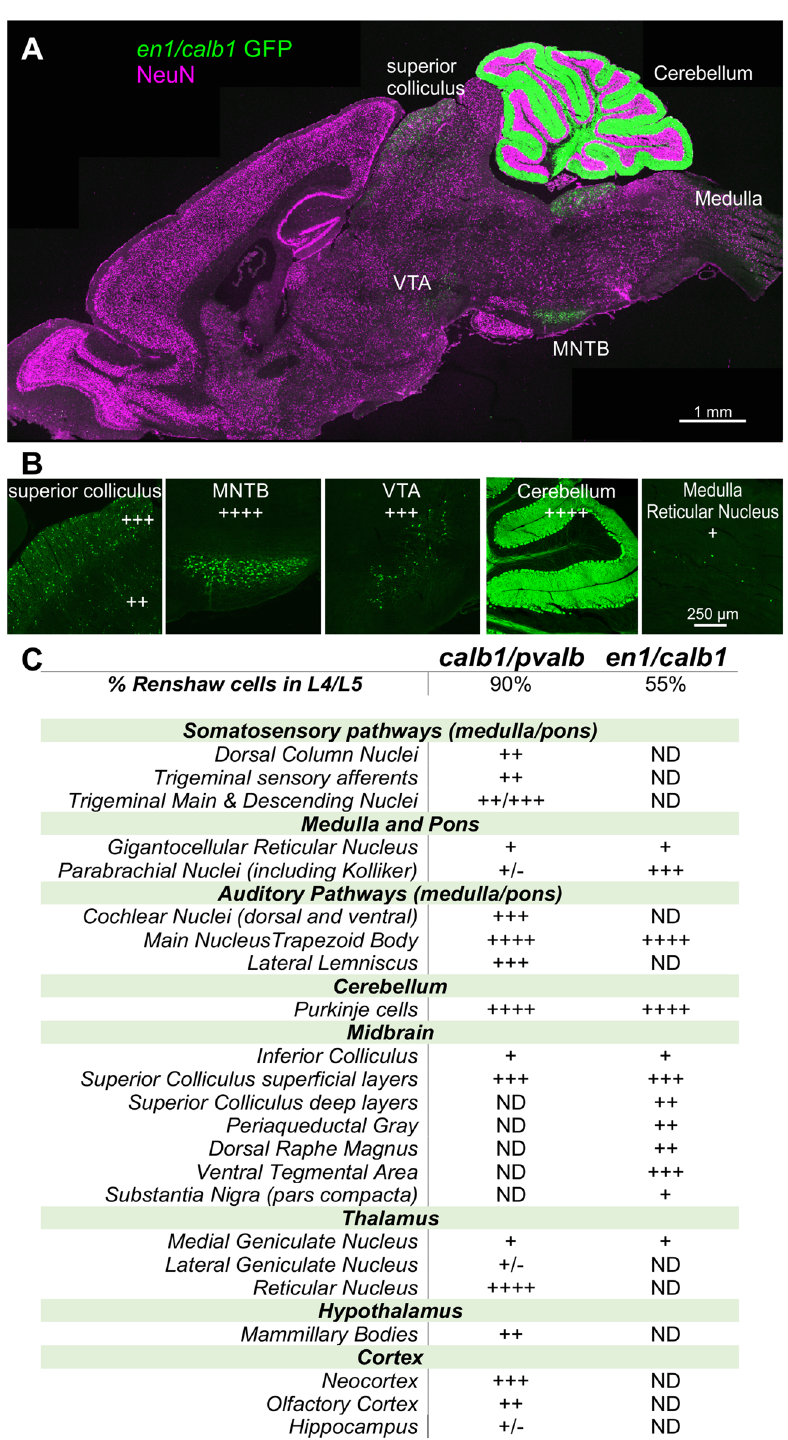
Figure 6. Distribution of brain cells targeted by Calb1/Pvalb and En1/Calb1 intersections. (A ) Genetic labeling in the brain of a Calb1 -dgCre :: En1 -Flpo :: R26 FLTG animal following two TMP injections at P21. Low magnification tiled single optical plane confocal image shows En1/Calb1 -EGFP neurons (green) and NeuN-IR (magenta) for anatomical localization (En1- tdT not shown). Regions with high densities of labeled cells include Purkinje cells, the main nucleus of the trapezoid body (MNTB), the superior colliculus, the ventral tegmental area (VTA), and the parabrachial region (not visible in this section). ( B) Higher magnification images of selected regions showing qualitative assessments of cell density (all are single optical sections). + + + + , all neurons labeled; + + + high density; + + medium density: + low density; ND non-detected. ( C) Comparison of brain nuclei containing neurons labeled by the En1/Calb1 intersection with 70% RC targeting efficiency and the Calb1/Pvalb intersection (R26 RCE:dual-EGFP reporter, TMP twice at P10) with 90% targeting